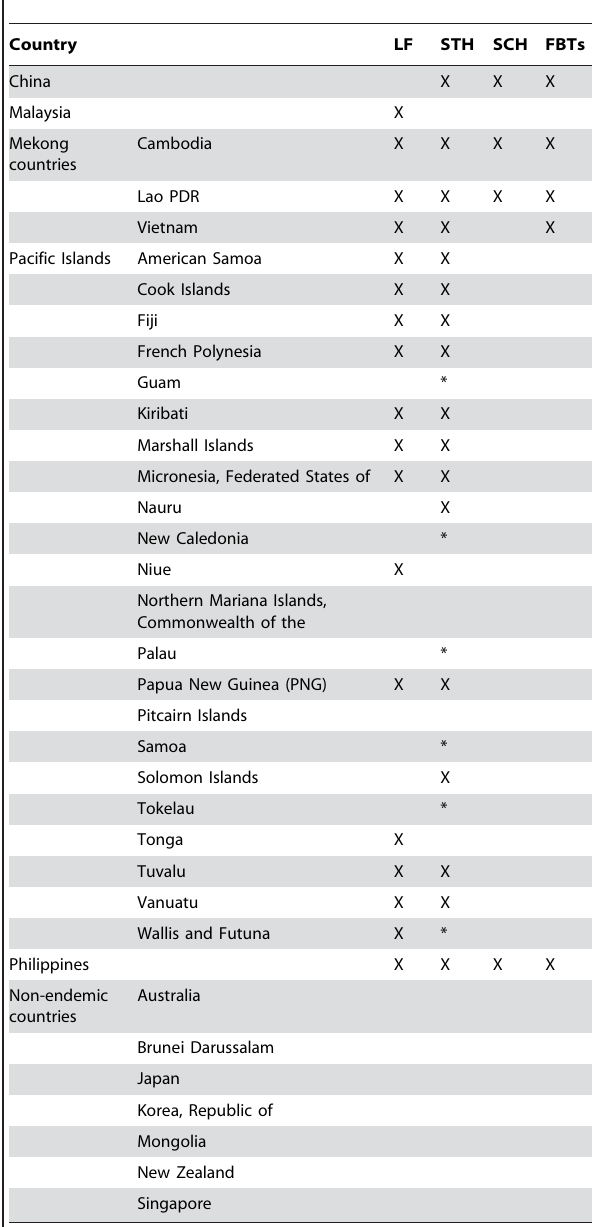
Table 1. Countries in the Western Pacific Region of WHO and Their Endemicity for Helminthiasis